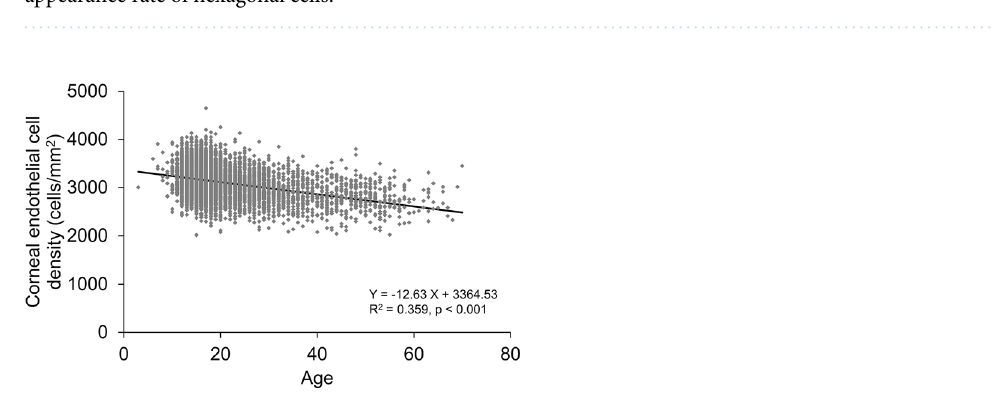
Table 2. Corneal endothelial cell density and morphology of ophthalmologically healthy Japanese eyes according to age category. ECD, corneal endothelial cell density; CV, coefficient of variation in cell area; 6A, appearance rate of hexagonal cells.